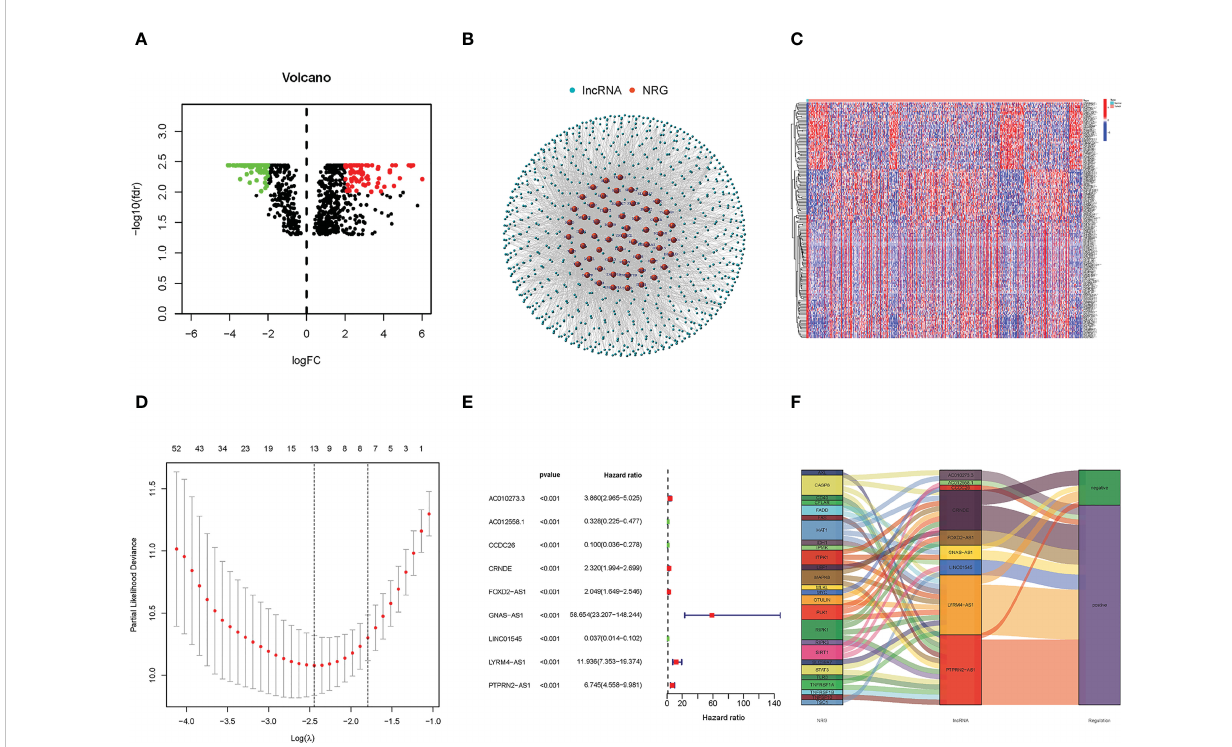
FIGURE 1 Identi fi cation of Necroptosis-related lncRNAs and construction of the prognostic model of necroptosis-related lncRNAs. (A) The heatmap of differentially expressed lncRNAs. The red points on the right of the vertical axis represent up-regulated in the tumor samples compared with normal samples. On the contrary, the green points on the lift of the vertical axis represent down-regulated. (B) The correlation of NRG and necroptosis- related lncRNAs. Red represents NRG, and blue represents necroptosis-related lncRNAs. (C) The expression heatmap of signi fi cantly differential expressed necroptosis-related lncRNAs, and up- and down-regulated lncRNAs were only exhibited 50 respectively. (D) The LASSO coef fi cient pro fi le of 9 necroptosis-related lncRNAs. (E) The forest plot of the lncRNAs extracted to construct the prognostic model. (F) The Sankey plot of necroptosis genes and related